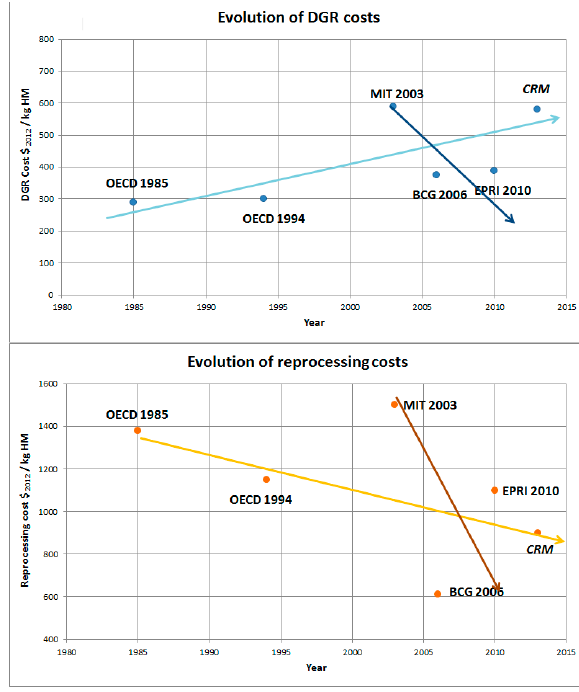
Figure 2. Evolution of deep geological repository (DGR) and reprocessing costs.